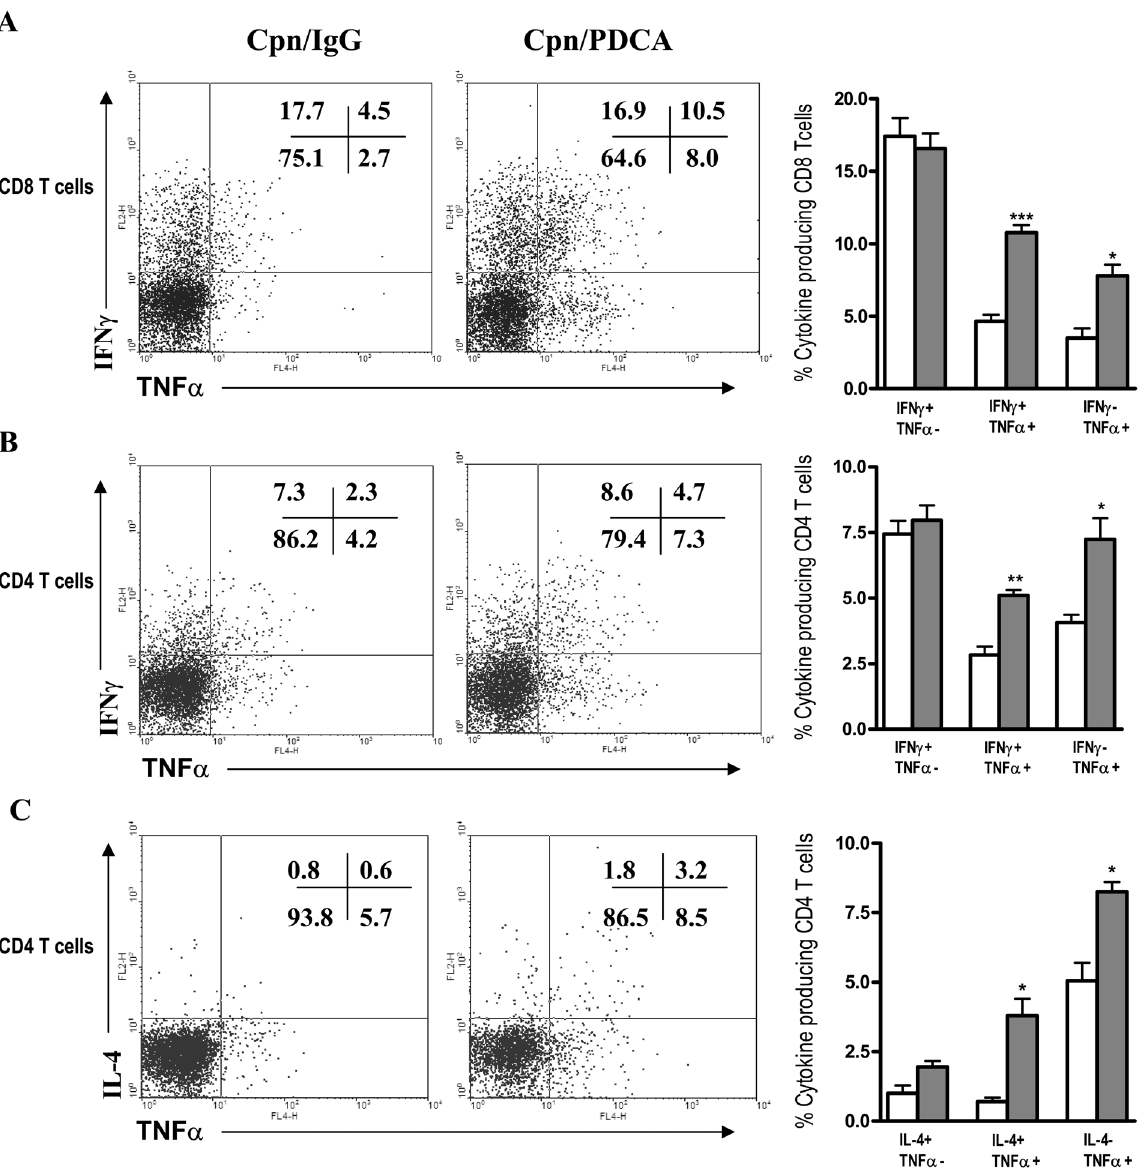
Figure 5. pDC deficiency leads to inflammatory type effector CD8 T and CD4 cell responses after Cpn infection. Lung T cells as described in the legends to Figure 4 were analyzed by multi-color intracellular cytokine staining. Shown are representative flowcytometry dot plot images and summary graphs depicting the nature of cytokine responses by T cells. Analysis was performed on gated CD3 + CD8 + cells and CD3 + CD4 + cells. Note increased inflammatory type-1 (IFN c + TNF a + ) CD8 ( A ) and CD4 T cells ( B ) and inflammatory Th2 type (IL-4 + TNF a + ) CD4 T cells ( C ) in the lungs of pDC depleted mice compared to the control group mice. At least three independent experiments were performed and the data from one representative experiment is depicted. Data expressed as mean 6 SD. *, p , 0.05, and ***, p ,